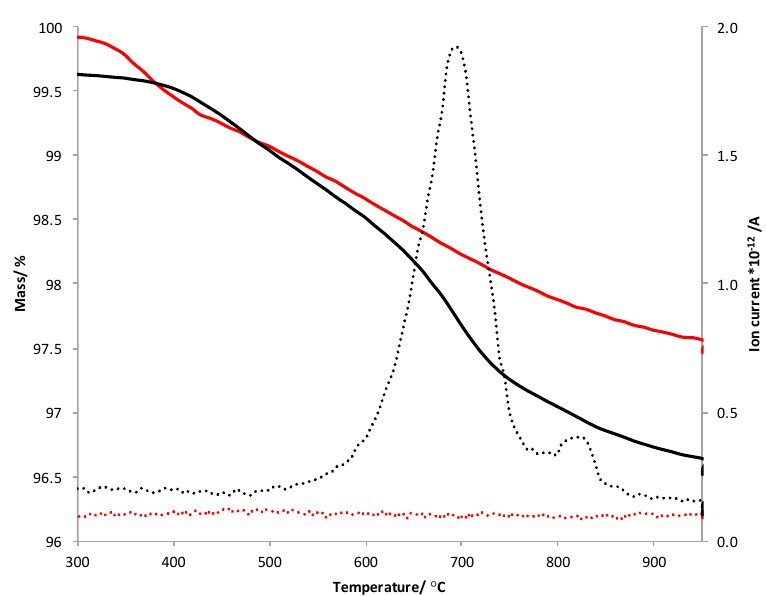
Figure 6. Plot of mass vs. temperature and ion current (for m/z = 44; CO 2 ) vs. temperature (under N 2 ) for SrFe 0.95 S 0.05 O 3- δ prepared in air (black) and O 2 (red), showing a mass loss associated with CO 2 in the air synthesised sample, which is eliminated after heat treatment in O 2 . Solid lines indicate %mass and dashed lines indicate ion current.